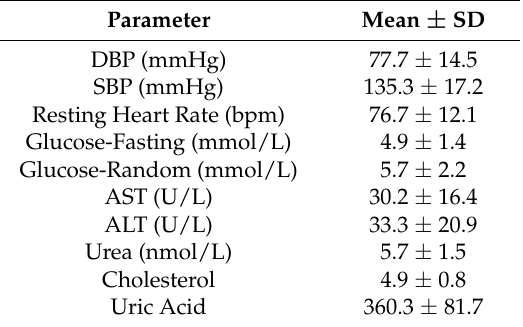
Table 2. Health parameters of the Hong Kong construction workers (sample size =